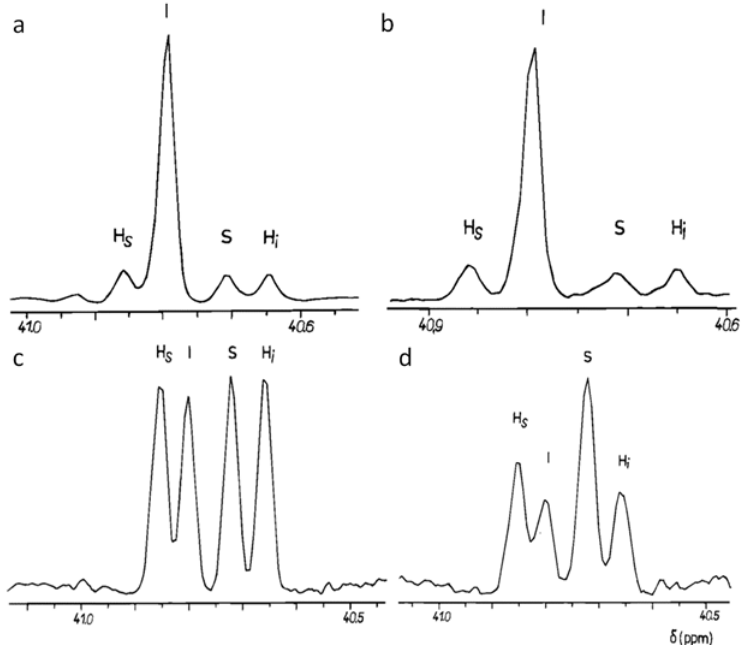
Figure 1. 13 C NMR spectra (methylene carbon region) of poly(BBL)s obtained via polymerization of (R)-BBL initiated with 18-crown-6 supramolecular complexes of ( a ) potassium methoxide and ( b ) potassium acetate; and poly(BBL)s obtained by polymerization of (R,S)-BBL initiated with 18-crown-6 supramolecular complex of potassium methoxide ( c ) at 20 °C, ( d ) at − 10 °C (methanol-insoluble fraction). (Modified with permission from Ref. [45]. Copyright 1996, American Chemical Society).